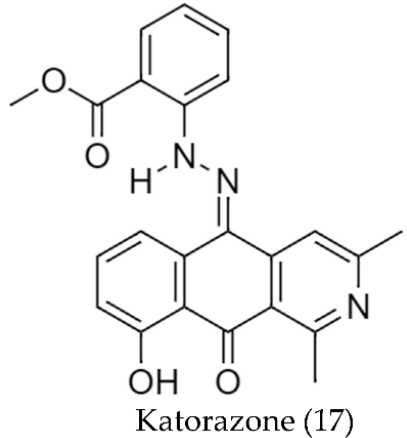
Figure 12. Chemical structures of katorazone.